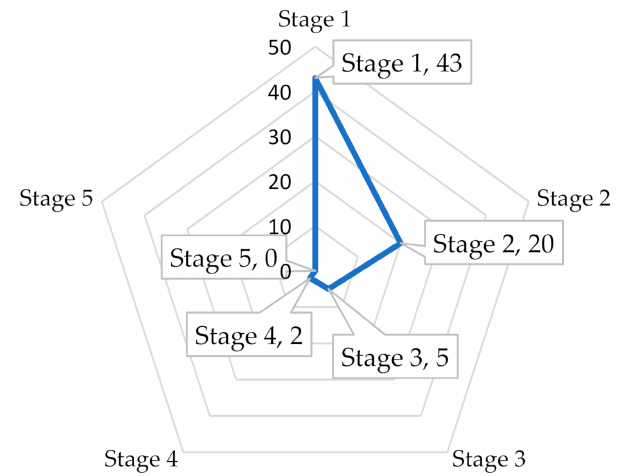
Figure 3. Implementation stage assessment of the Industry 4.0 technologies in the enterprise. Question 4 aimed to indicate whether a person or a team responsible for the Industry 4.0